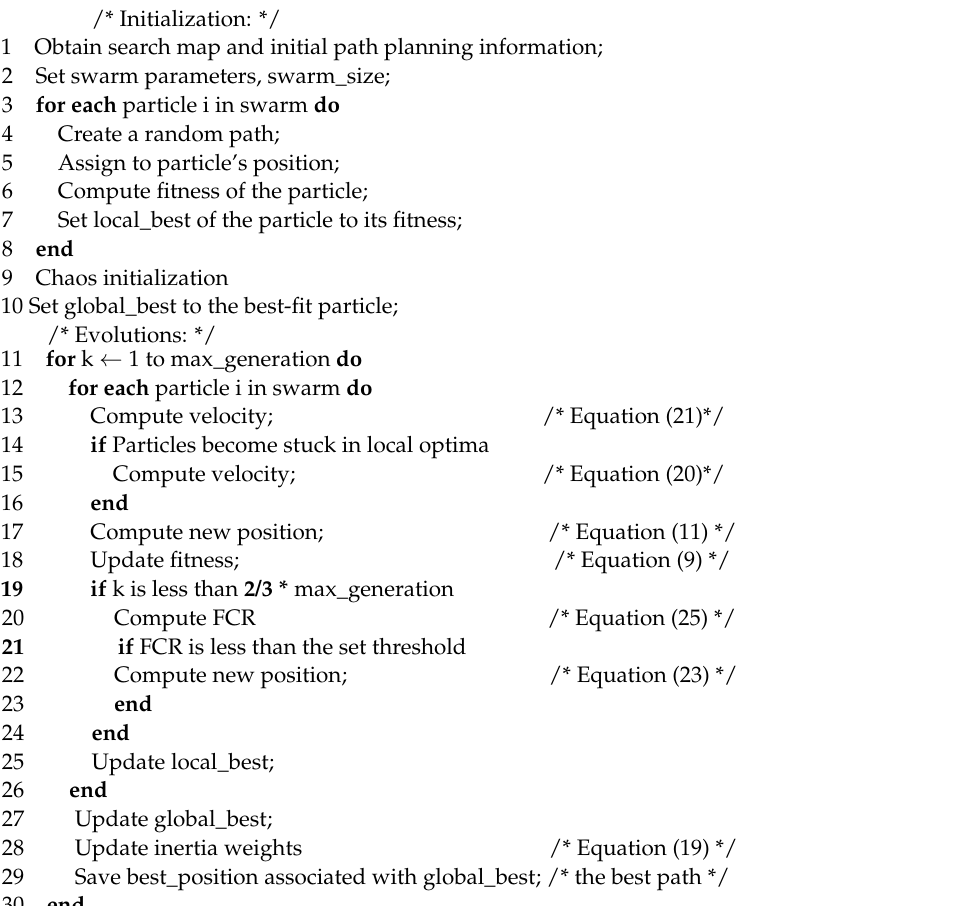
Algorithm 1 IC-VAINDIWPSO